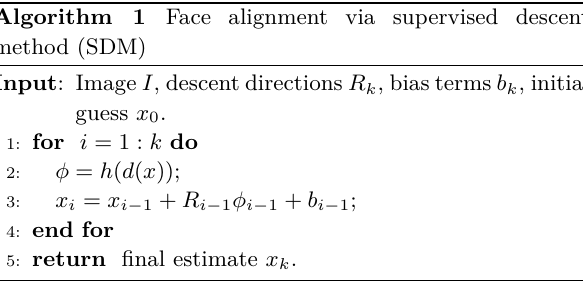
Algorithm 1 Face alignment via supervised